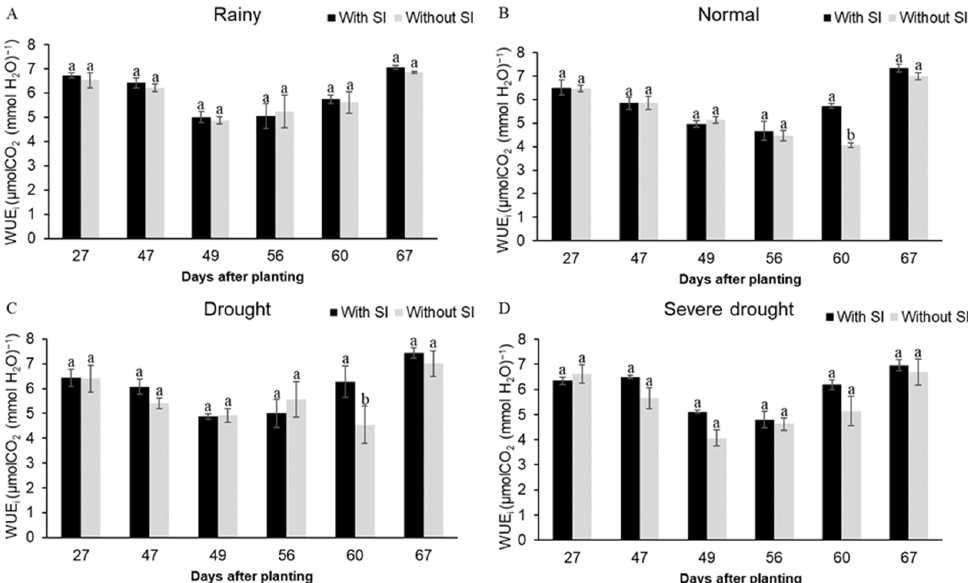
Figure 10. Instantaneous water use efficiency in maize leaves under Rainy ( A ), Normal ( B ), Drought ( C ) and Severe drought ( D ) scenarios, showing sampling dates and presence or absence of supplemental irrigation (SI) with brackish water of ECw = 4.5 dS m − 1 . For each sampling date, means followed by the same letters do not differ ( p ≥ 0.05) from each other according to the Tukey test. Error bars represent the standard error of the mean ( n =